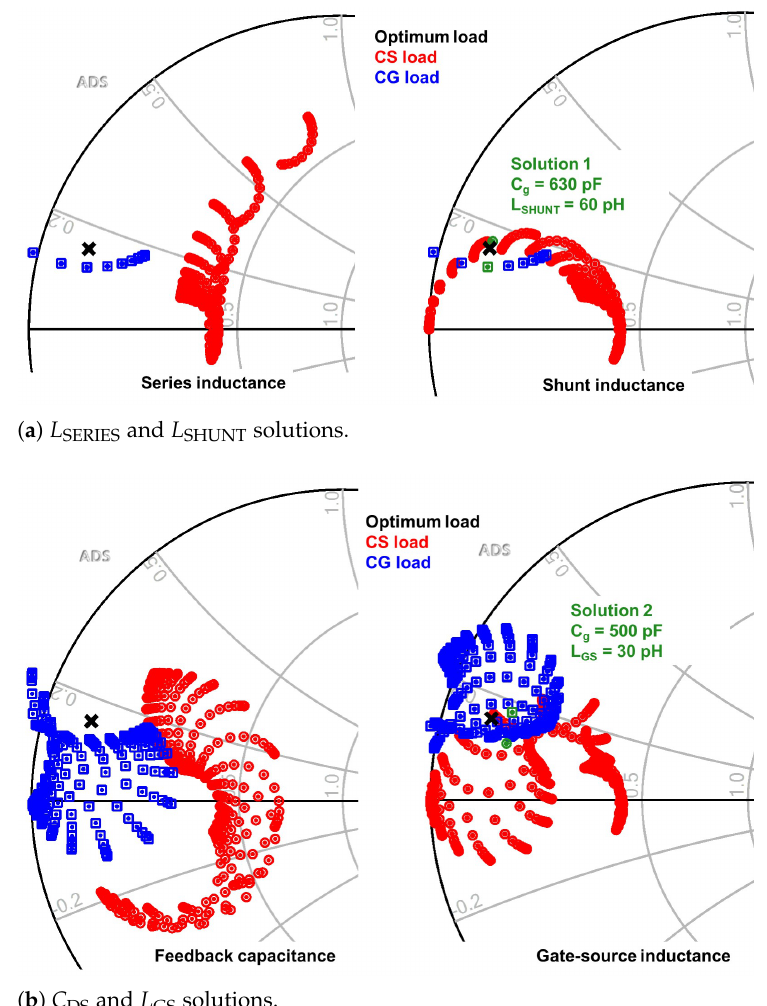
Figure 9. Load of CS (red circles) and CG (blue squares) stages as a function of ISMN components compared to Z opt (black